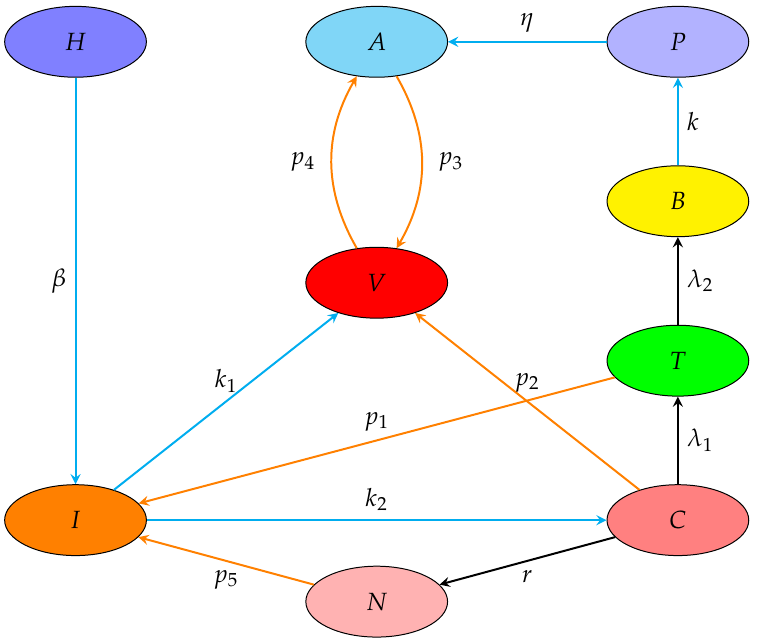
Figure 1. Schematic diagram of the proposed mathematical model. The cyan arrows indicate production, black arrows indicate activation, and orange arrows indicate